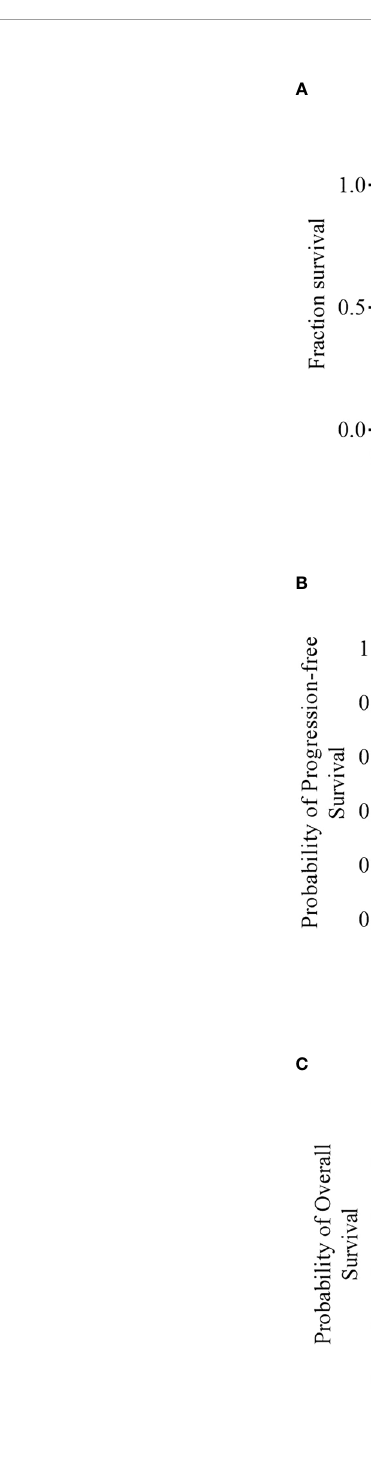
FIGURE 3 Median follow-up time, Progression-free Survival, and Overall Survival. Panel (A) shows the Kaplan – Meier estimate of the median follow-up time among the 6 patients who received an infusion of NAHTC cells. Kaplan – Meier estimates of progression free survival and overall survival among the 5 patients who were evaluated for treatment response are shown in Panels (B) and (C) ,